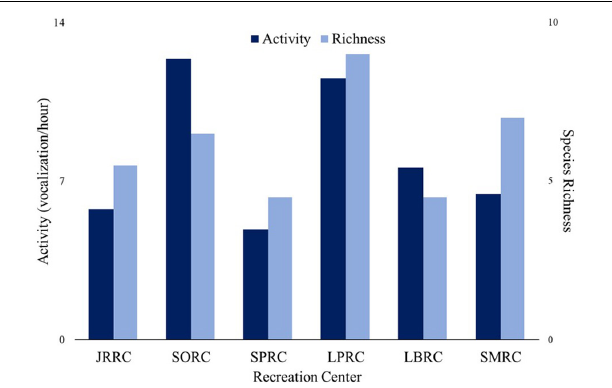
FIGURE 4 | Average bird activity (vocalizations/hour) and bird species richness on roofs on six New York City Department of Parks and Recreation recreation center roofs. Roofs were monitored before (2010) and after (2011, 2012, and 2014) green roof plot installation. Sorrentino Recreation Center was only monitored in 2010 and 2011. JRRC, Jackie Robinson Recreation Center; SORC, Sorrentino Recreation Center; SPRC, Sunset Park Recreation Center; LPRC, Lyons Pool; LBRC, Lost Battalion Hall Recreation Center; SMRC, St. Mary’s Recreation